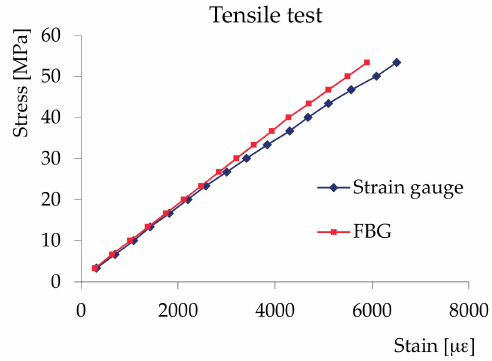
Figure 7. Tensile test: stress–strain diagram.